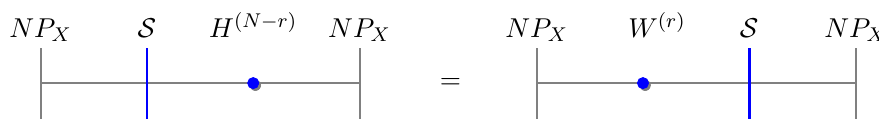
Figure 17 . The computations leading to an unknot in S 3